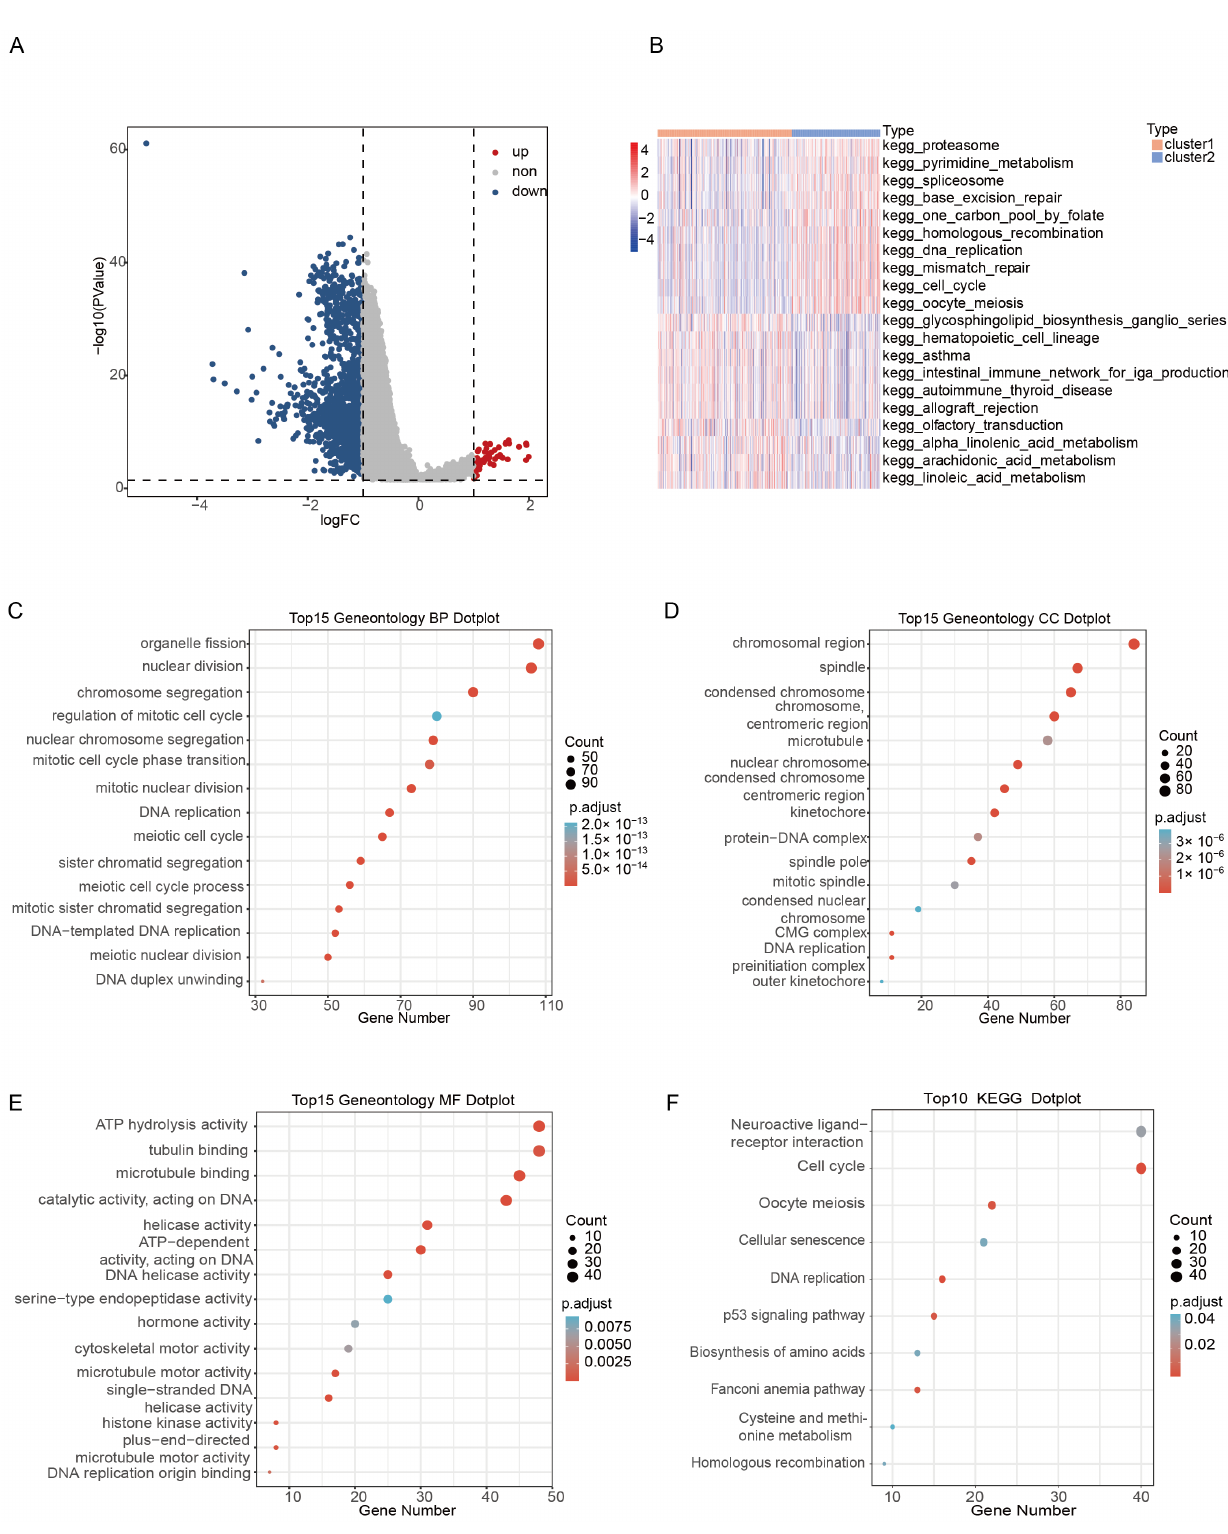
Figure 4. Difference analysis and functional analysis between m6A/m5C subtypes. ( A ) Volcano map of DEGs between the m6A/m5C subtypes. ( B ) The 20 biological pathways of two m6A/m5C subtypes by GSVA. Red represents the activation of biological pathways and blue represents the inhibition of biological pathways. ( C ) BP results of DEGs in m6A/m5C subtypes. ( D ) CC results of DEGs in m6A/m5C subtypes. ( E ) MF results of DEGs in m6A/m5C subtypes. ( F ) KEGG results of DEGs in m6A/m5C